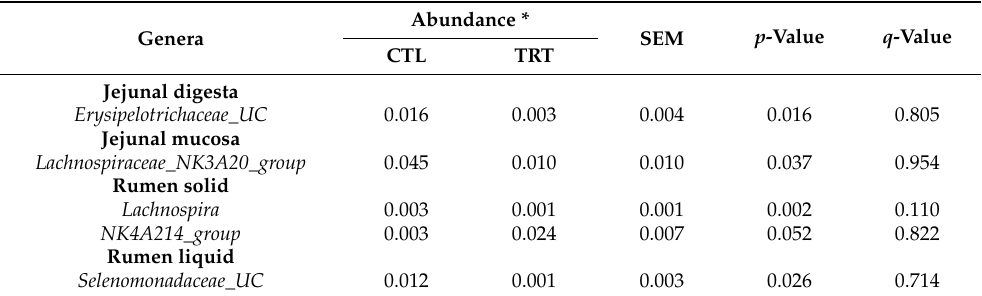
Table 4. Genera within the 50 most abundant showing differences ( p ≤ 0.05) between control (CTL) and MCE-fed (TRT) calves.